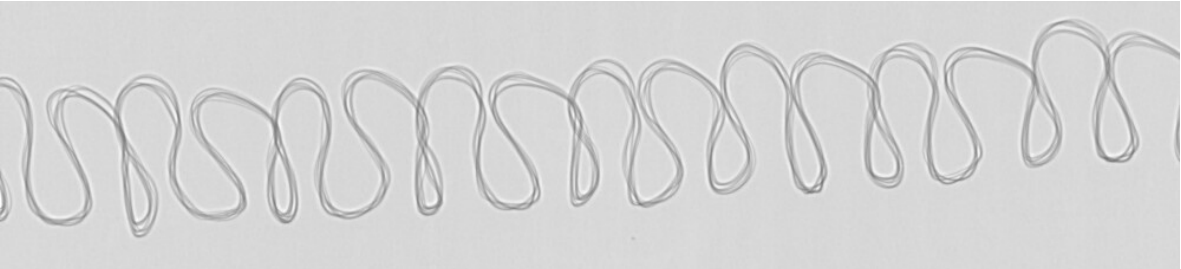
Figure 11. Xray microscopy image of a SJ STEEL track after 10 wash cycles showing no damages to the steel